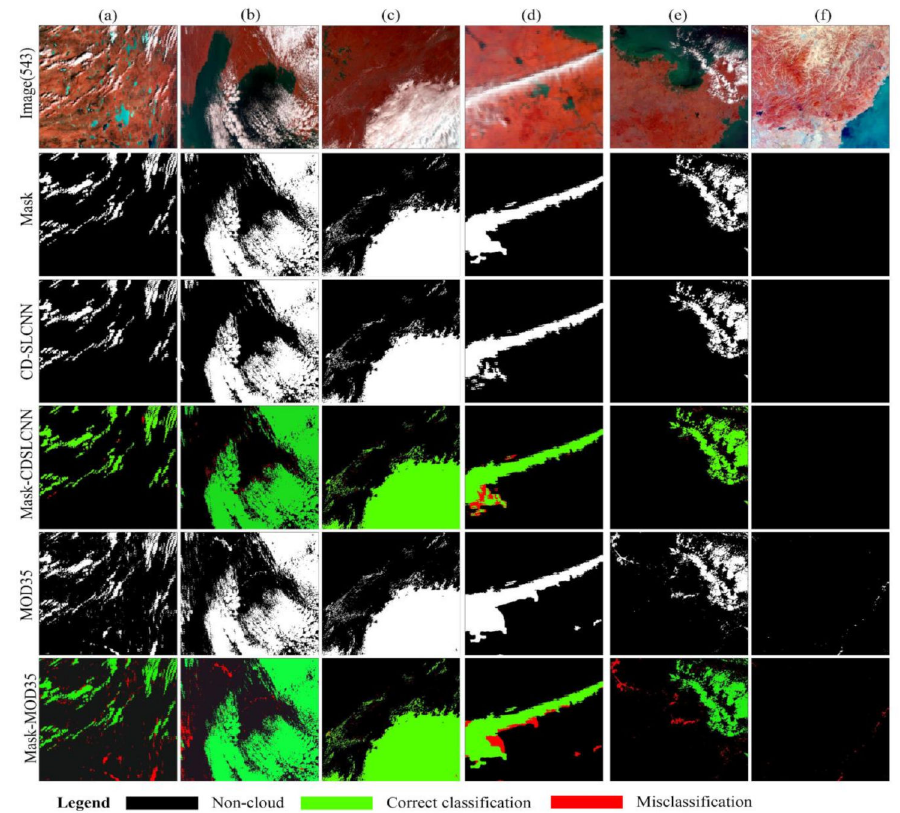
Figure 9. Qualitative comparison of cloud detection results in MODIS images over diverse underlying surfaces: ( a ) vegetation and inland water areas, acquired on 15 January 2013; ( b ) ocean areas, acquired on 8 October 2018; ( c ) forest areas, acquired on 29 December 2017; ( d ) vegetation and ocean areas, acquired on 8 October 2018; ( e ) ocean areas, acquired on 9 October 2018; ( f ) mountain and building areas, acquired on 28 November